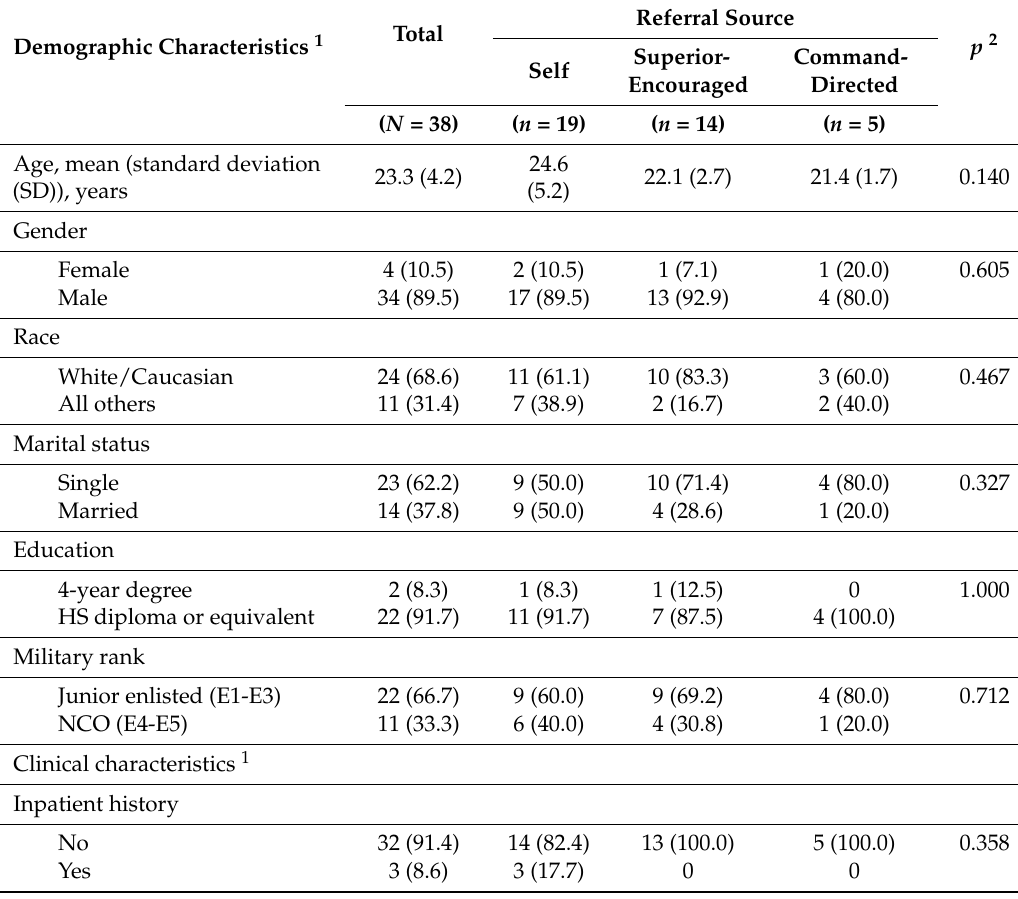
Table 1. Phase 1: Demographic and clinical characteristics of United States Marine Corps mental health treatment-seekers ( N = 38)